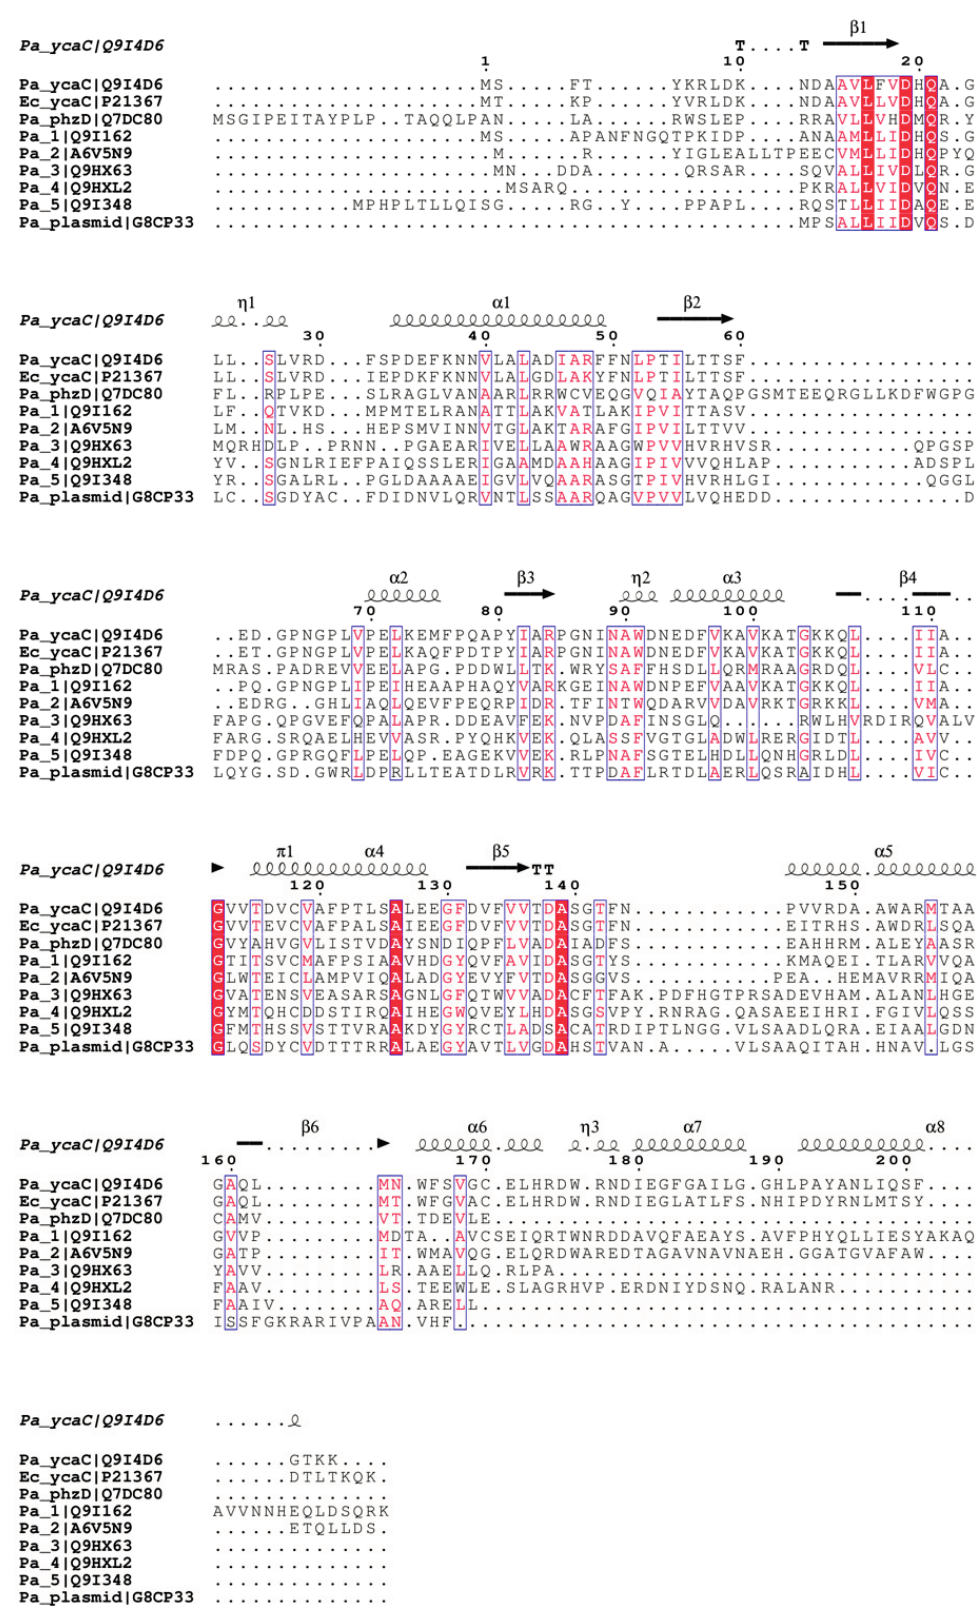
Figure 3. Sequence alignment of YcaC homologues with secondary structural elements annotated based on the Pa YcaC crystal structure presented here. Conserved residues are highlighted in red (highly conserved) and white on red background (absolutely